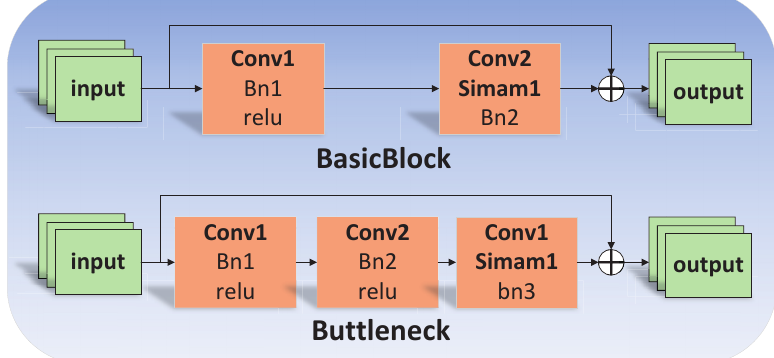
Figure 5. Structure of BasicBlock and